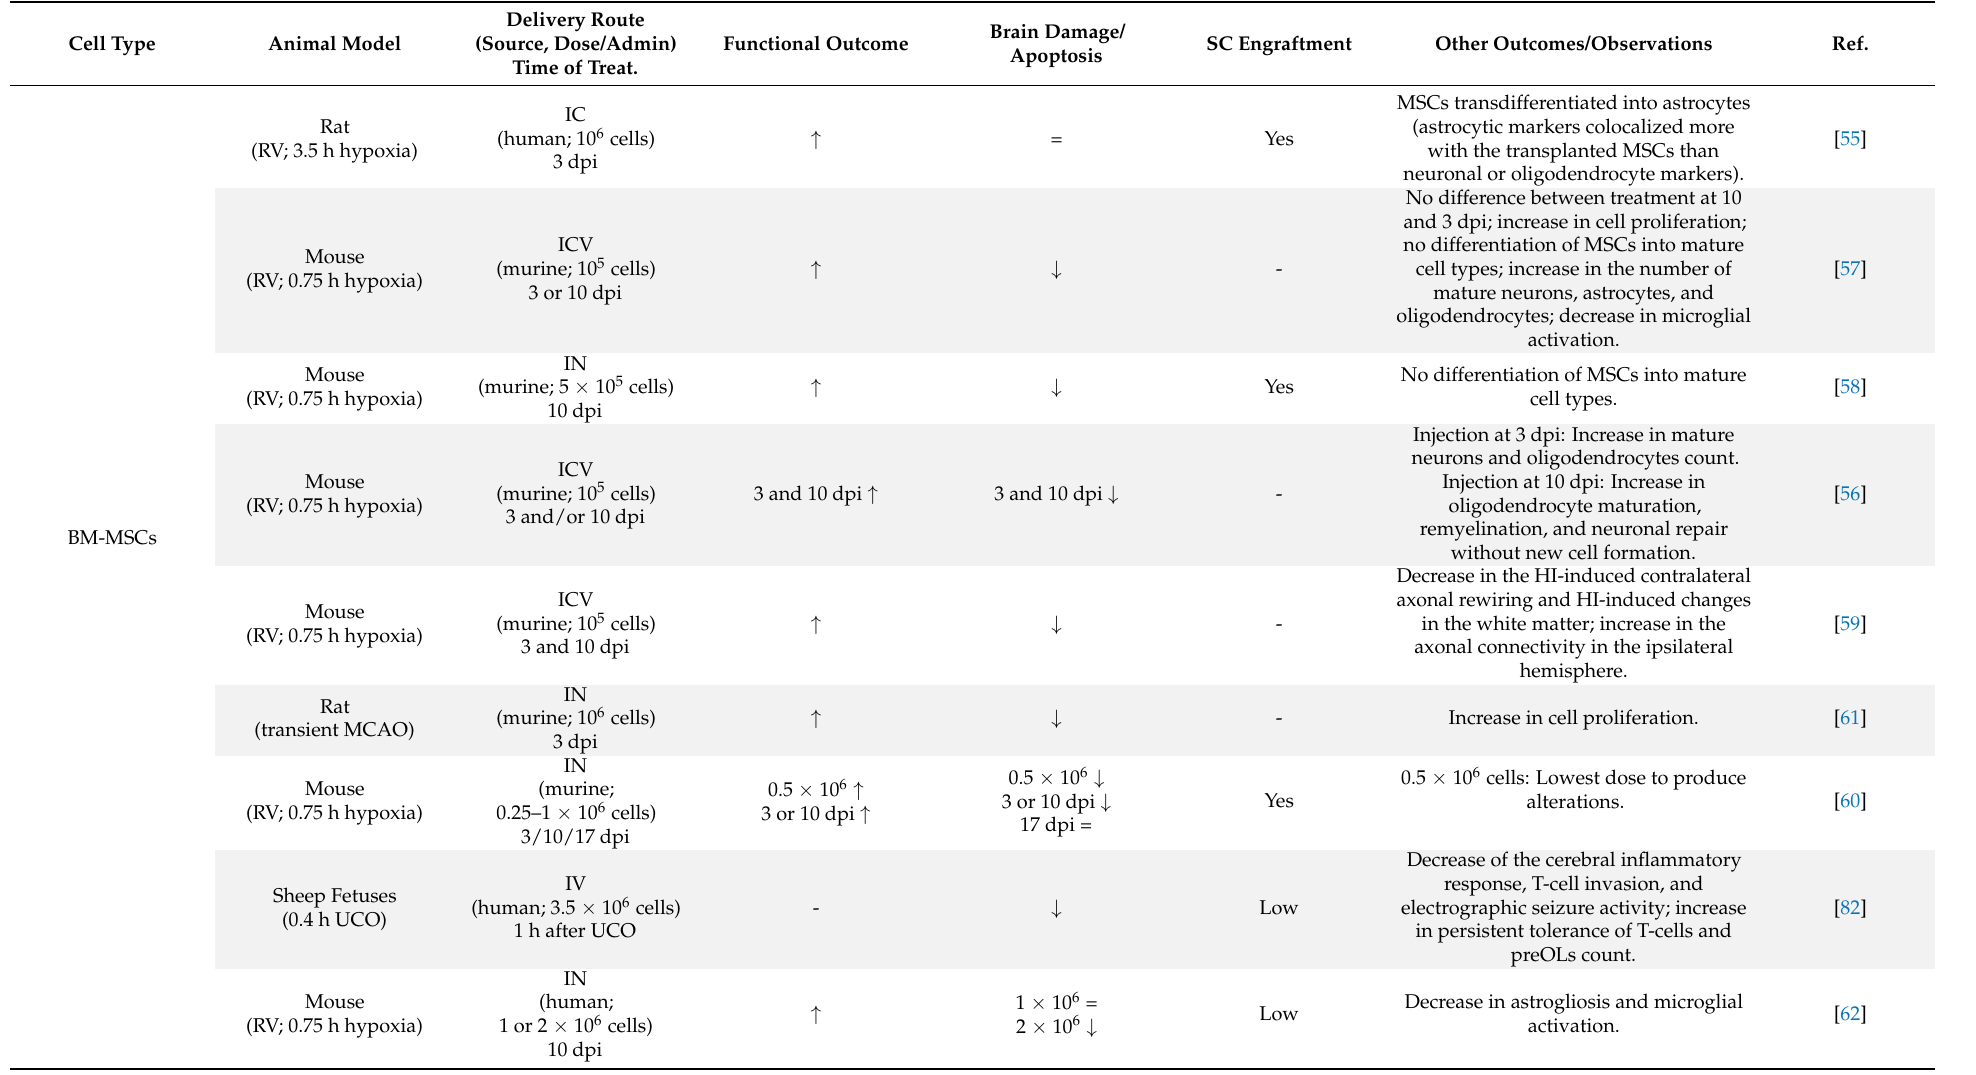
Table 3. Studies focusing on the therapeutic potential of bone marrow-derived mesenchymal stem/stromal cells in animal models of hypoxic-ischemic encephalopathy. Cell